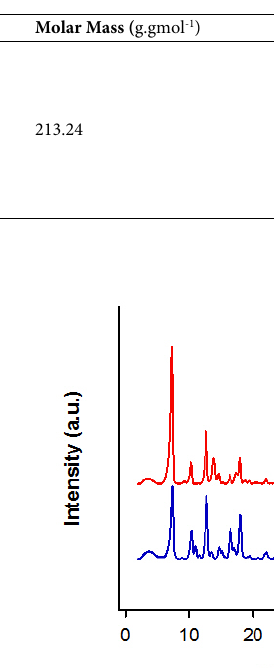
Table 1. General information of PHP